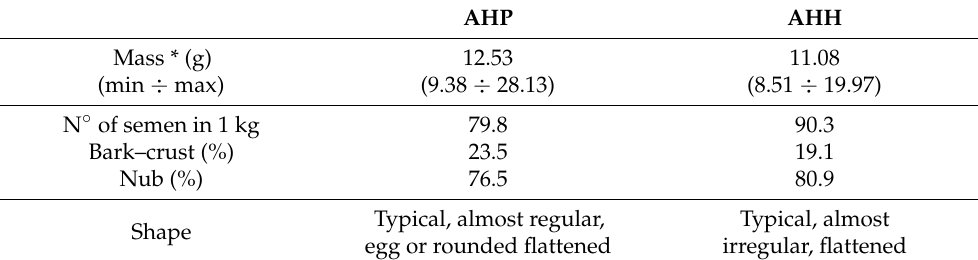
Table 2. Some physical properties and biometric characters of horse chestnut seeds of different botanical origins from University Campus of Modena city (harvested in the year